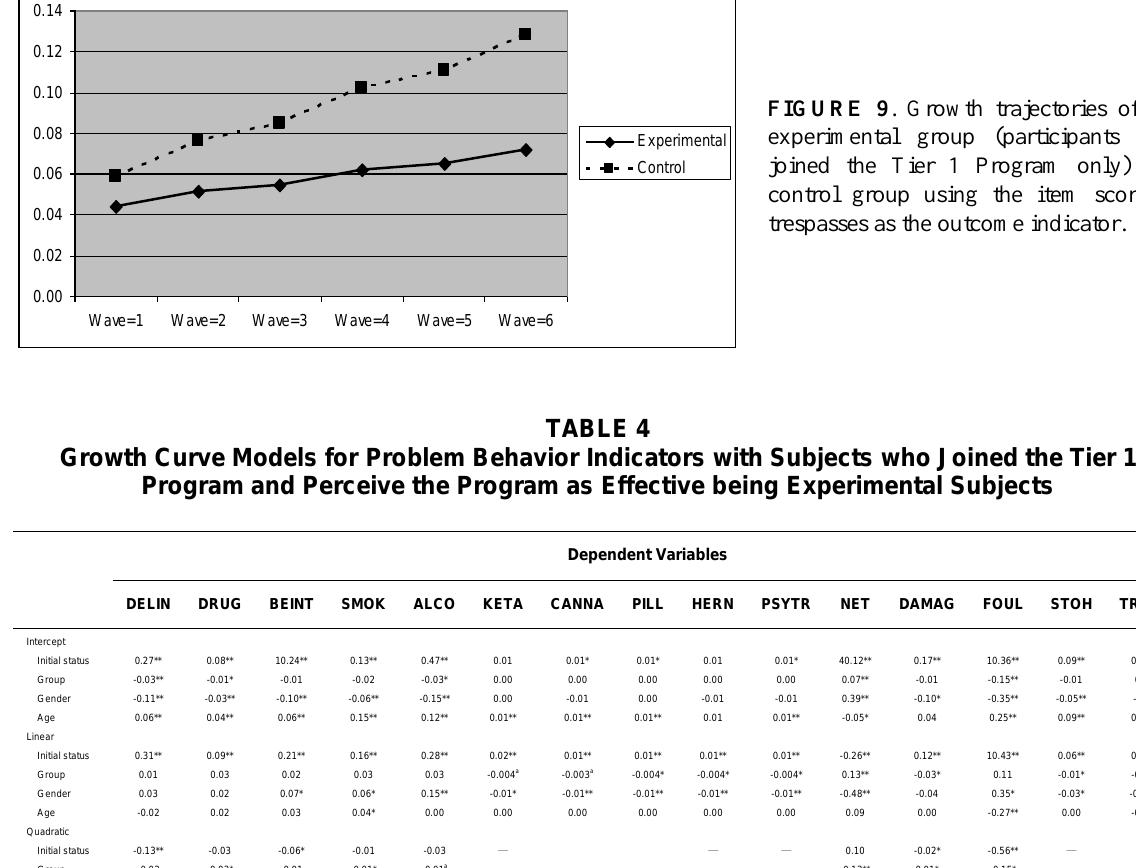
FIGURE 9 . Growth trajectories of the experimental group (participants who joined the Tier 1 Program only) and control group using the item score of trespasses as the outcome